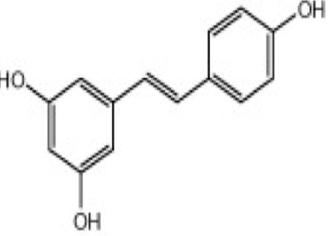
Figure 3. Trans resveratrol Structure (3,5,4 ′ -trihydroxy-trans-stilbene).